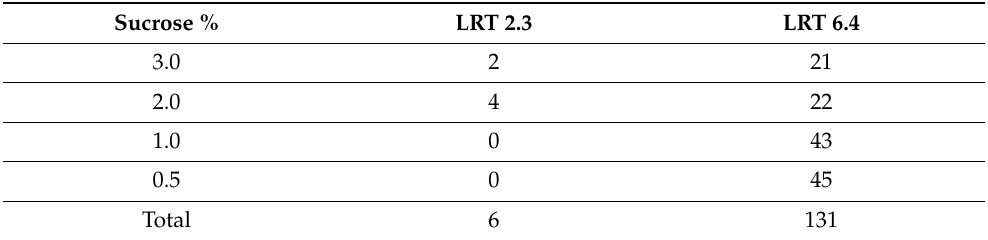
Table 1. Chi-Square ( Xi 2 ) statistical analysis of the total number of regenerated plantlets per hairy root line during 30 days on MS/B5 medium containing different sucrose concentrations. It shows significant difference ( p < 0.01) between both lines. Degrees of freedom (df) = 3.